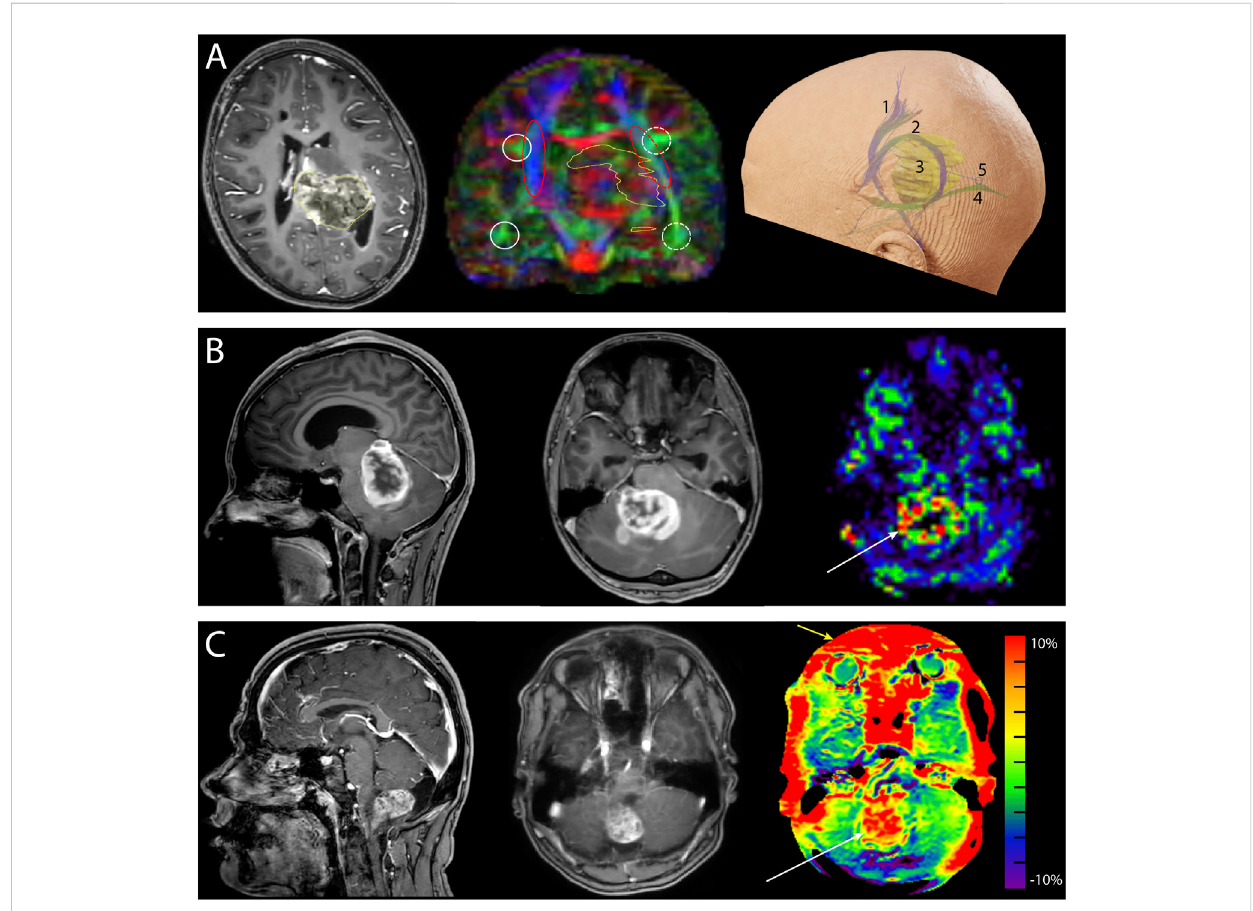
FIGURE 2 Neurosurgical cases demonstrating the added value of advanced MRI. (A) Preoperative images of a 10-year-old girl with a diffuse midline glioma (H3K27 mt) originating from the left posterior thalamus and mesencephalon and expanding into the atrium of the left ventricle. Left : the transverse T1- weighted contrast-enhanced image shows enhancement of the tumor (yellow outline). Center: the coronal fractional anisotropy color-coded map (single-shelldiffusionMRI,16directions)showsleft-rightasymmetrydemonstratingthedisplacementof fi berscausedbythetumor(yellowoutline). Thewhitecirclesdepictthearcuatefasciculus,andtheredovalsdepictthecorticospinaltracts.Solidlinesdepicttheunaffectedside,andthedashedlines show the affected side. Right: reconstruction of the corticospinal tract 1), arcuate fasciculus 2), tumor 3), and optic radiation 4). A parietal surgical approach posteriorto the arcuate fasciculus and superiorto theoptic radiation5)was chosen for tumormass reduction and histopathological diagnosis. (B) Preoperative images of a 17-year-old girl with neuro fi bromatosis type 1 and a space-occupying lesion in the fourth ventricle. Left : the sagittal T1- weighted contrast-enhanced images. The differential diagnosis was pilocytic astrocytoma or high-grade glioma. Center : transverse T1-weighted contrast-enhancedimage. Right :thehyperperfusion (whitearrow)oftheunquanti fi edarterialspinlabelingimagemakesdiagnosingahigh-gradeglioma more probable. Histopathological examination revealed a high-grade glioma with pilocytic features. (C) Preoperative images of a 17-year-old boy with a pilocytic astrocytoma. Left: sagittal T1-weighted contrast-enhanced image. Center: transverse T1-weighted contrast-enhanced image. Right: amide- proton transfer-weighted (APTw) image. Note the hyperintense region (white arrow) that matches the contrast enhancement on T1-weighted contrast- enhanced image.The redouterrim (yellow arrow)oftheAPTw imageislikelycaused bysusceptibility-weightedair-tissueartifacts. Ethical approval from the local medical ethics committee was obtained for this